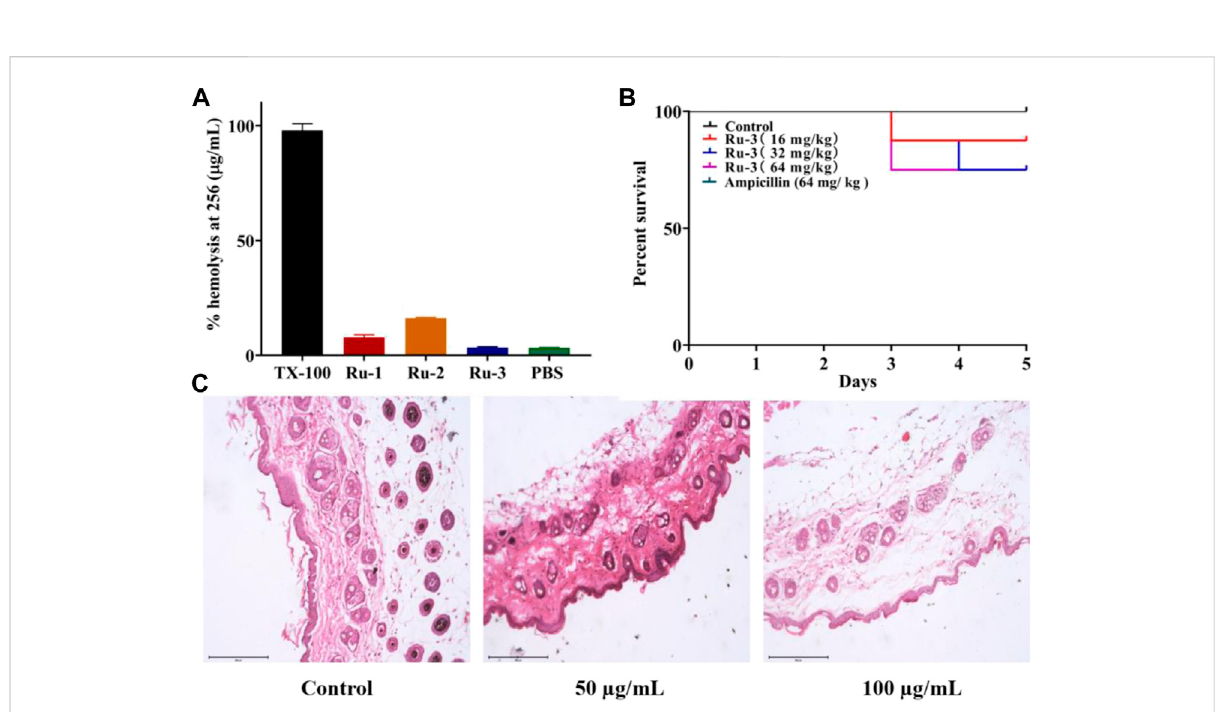
FIGURE 15 TestresultsofRucompoundstoxicity (A) %hemolysisat256 μ g ml − 1 ofRucompounds. (B) Kaplan-Meiersurvivalcurves.DeterminationofRu-3 toxicityintheinsect modelGalleriamellonella(Ampcillin ’ scurvecoincides withcontrol ’ scurve.)Larvaewereinjected with 5 µLofwater (control),or Ru-3 (4 – 512 mg kg − 1 ). The larvae were incubated at 37.5 ° C and live/dead scores were conducted at 120 h (C) H&E staining images of the infected tissues with different